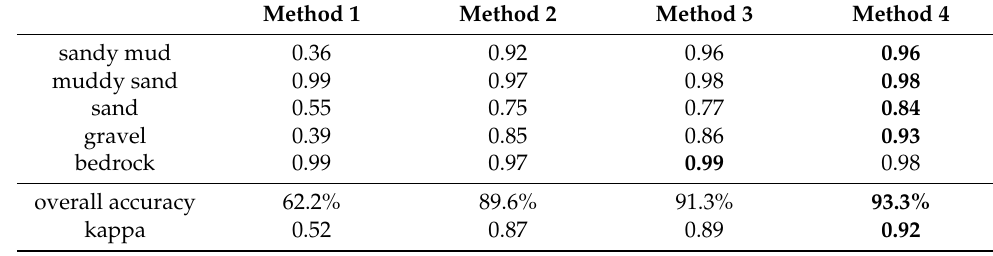
Table 3. Classification accuracy of four methods.